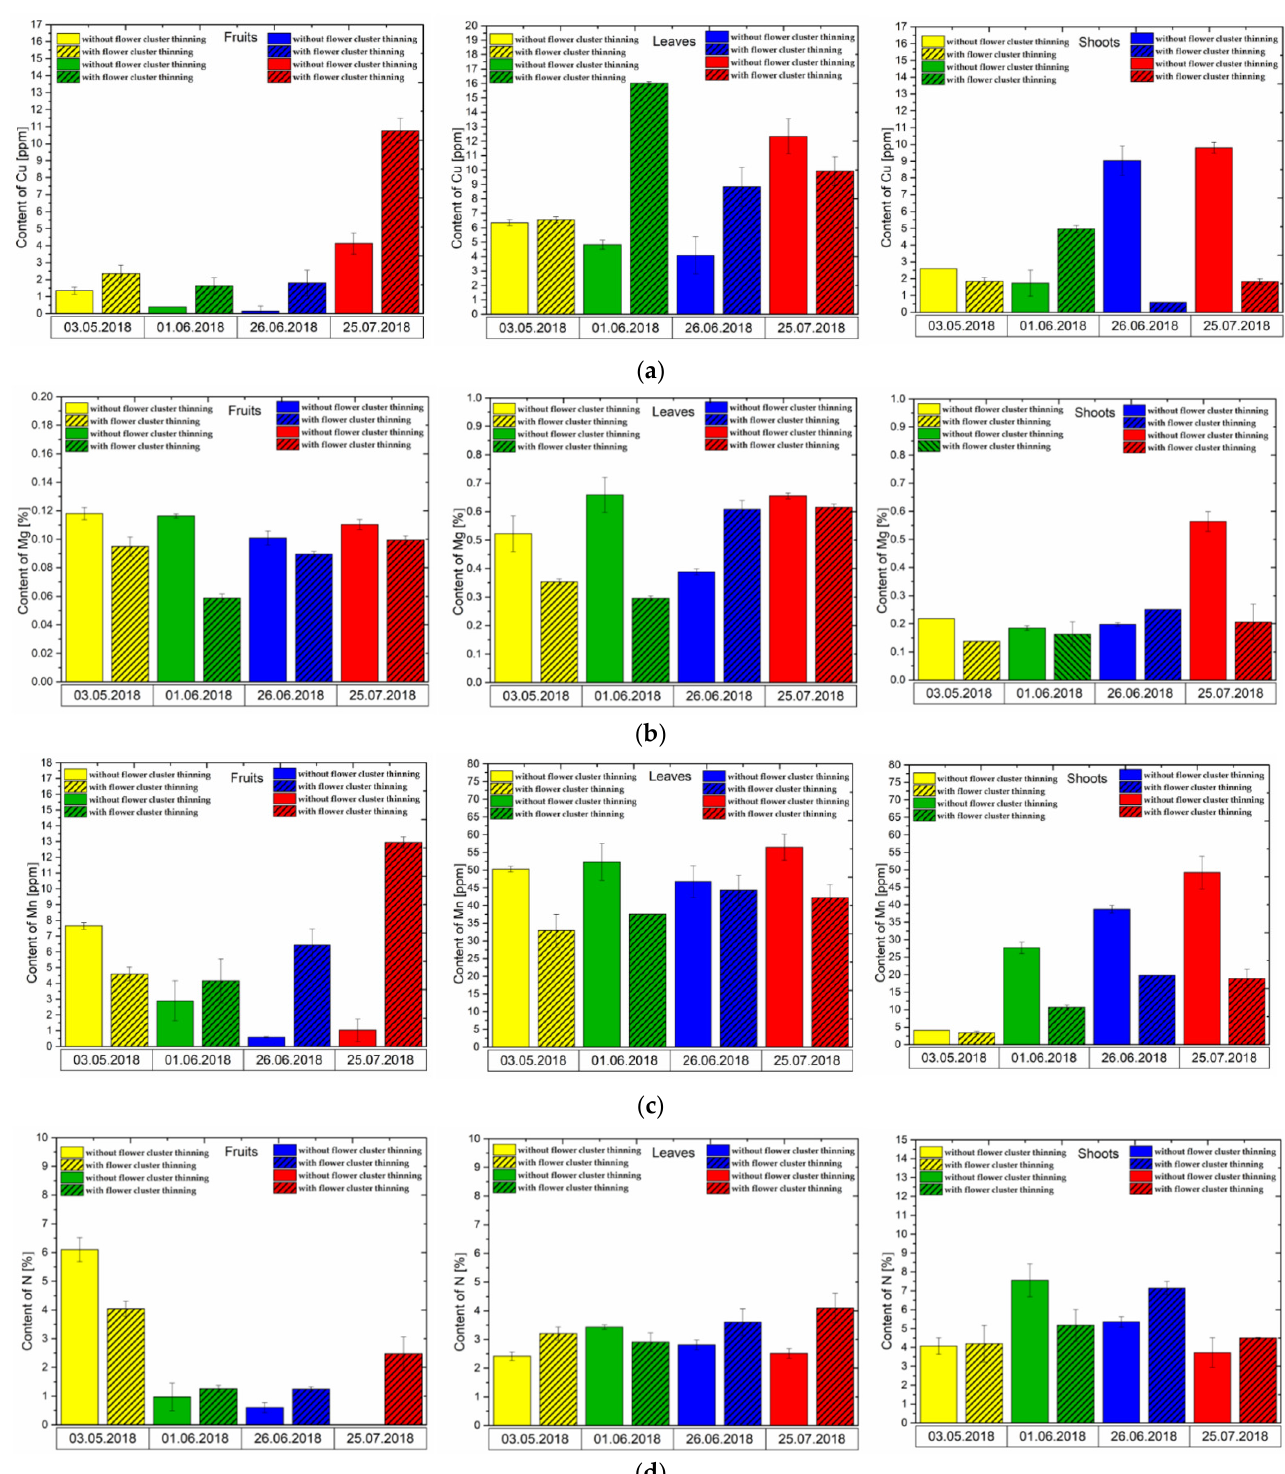
N and Fe (Tables S1 and S2). Statistically significant (at 0.05 level) correlation coefficients were observed for 95 from 120 pairs of the observed traits (Table S3, Figure 9).